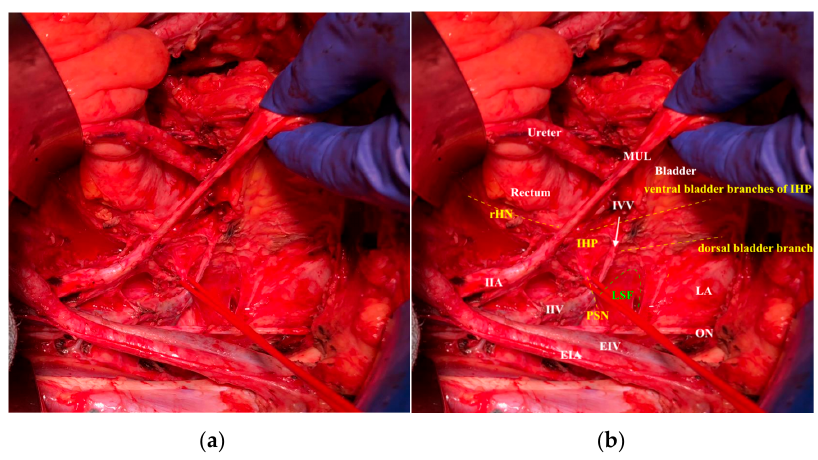
Figure 4. The lateral appearance of the right inferior hypogastric plexus after nerve-sparing radical hysterectomy: ( a ) original photo; ( b ) with explanation of the anatomic structures. MUL: medial umbilical ligament, IIA: internal iliac artery, IIV internal iliac vein, EIA: external iliac artery, EIV: external iliac vein, ON, obturator nerve, IVV: inferior vesical vessels, PSN: pelvic splanchnic nerves, LSF: lesser sciatic foramen, LA: levator ani, IHP: inferior hypogastric plexus, rHN: right hypogastric nerve.